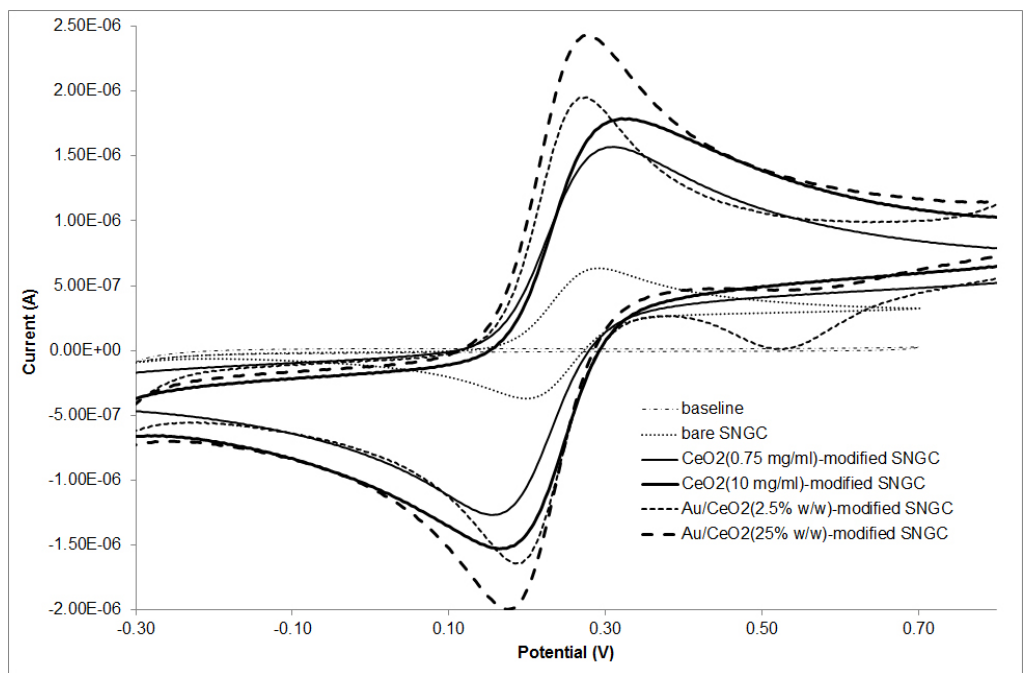
Figure 4. CV voltammograms corresponding to different configurations of the